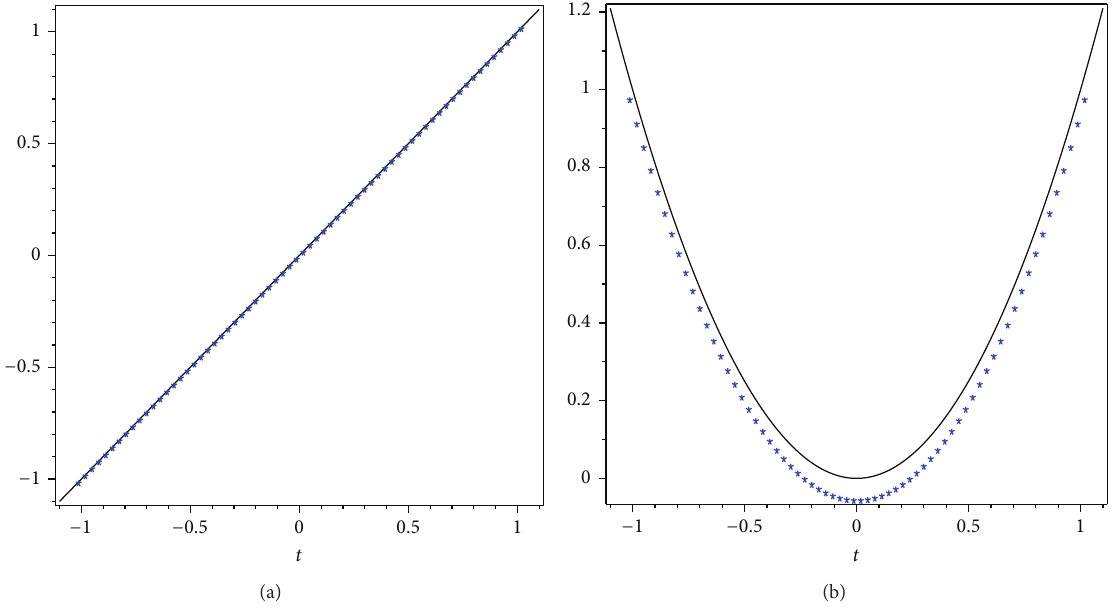
Figure 2: Polynomial reproduction of scheme S ̃𝑃,̃ h with scheme mask symbol (65); solid line denotes the true polynomial and asterisk 0 ,̃Φ 0 point denotes the discrete data using 5 times iteration of subdivision operator; (a) 𝑝(𝑡) = 𝑡 ; (b) 𝑝(𝑡) = 𝑡 2 .